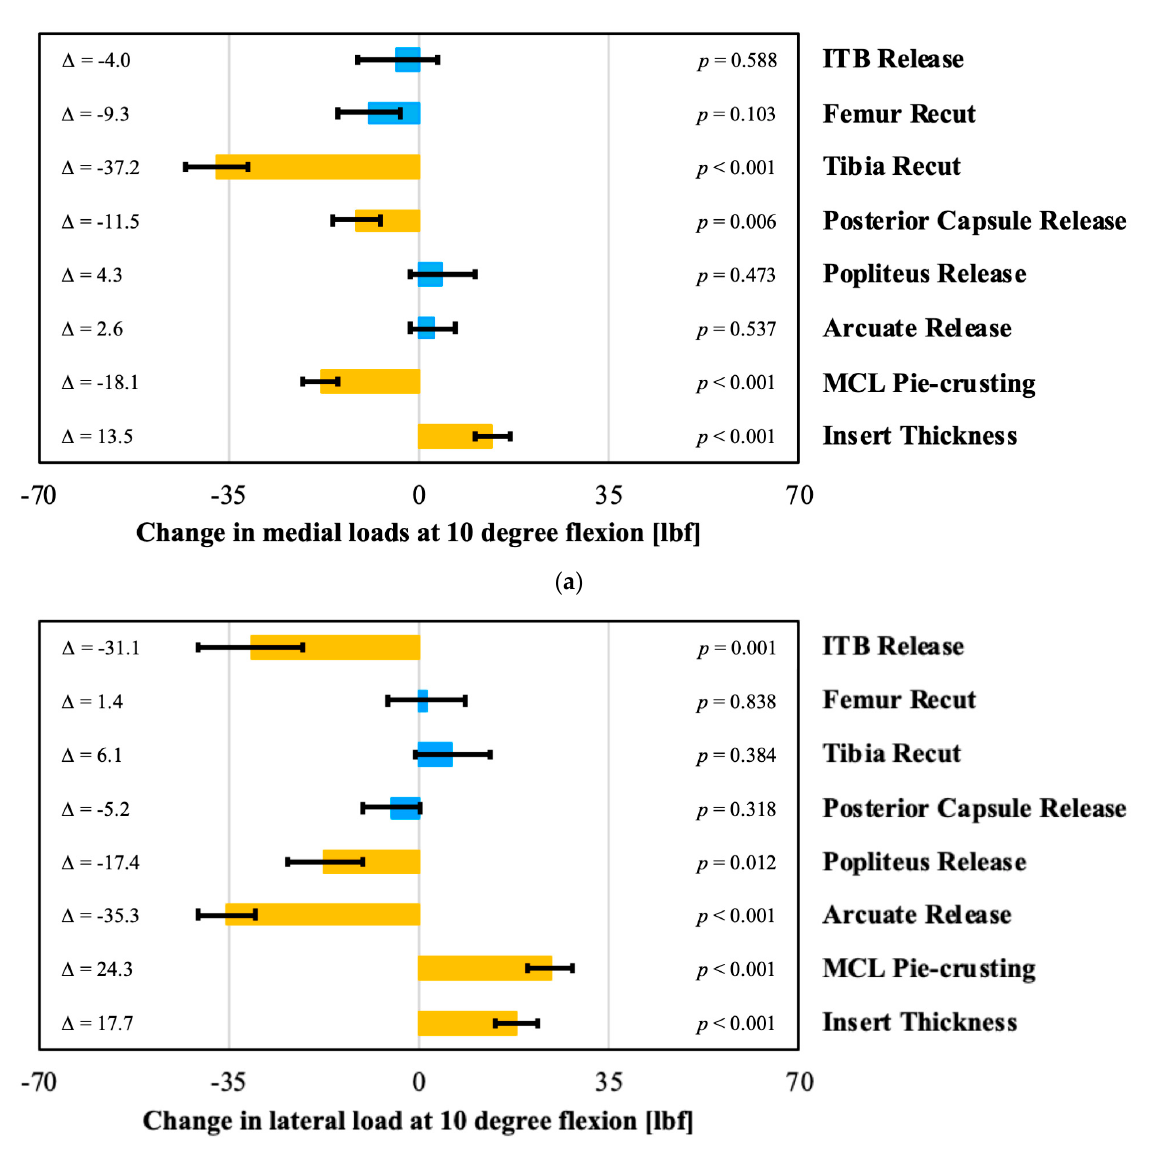
Figure 4. Evaluation of the effect of surgical correction on ( a ) medial ( b ) and lateral loads in 10 degree of flexion, with orange bars indicating statistically significant effects. Each change is the post-correction value minus the pre-correction value.